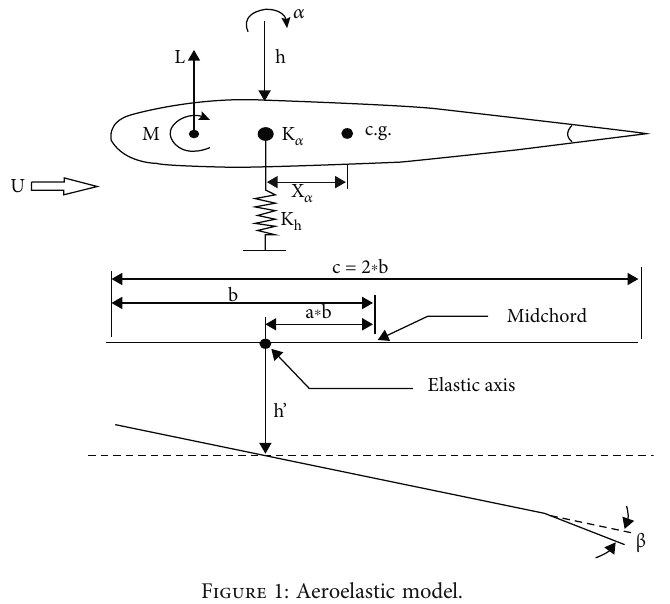
Figure 1: Aeroelastic